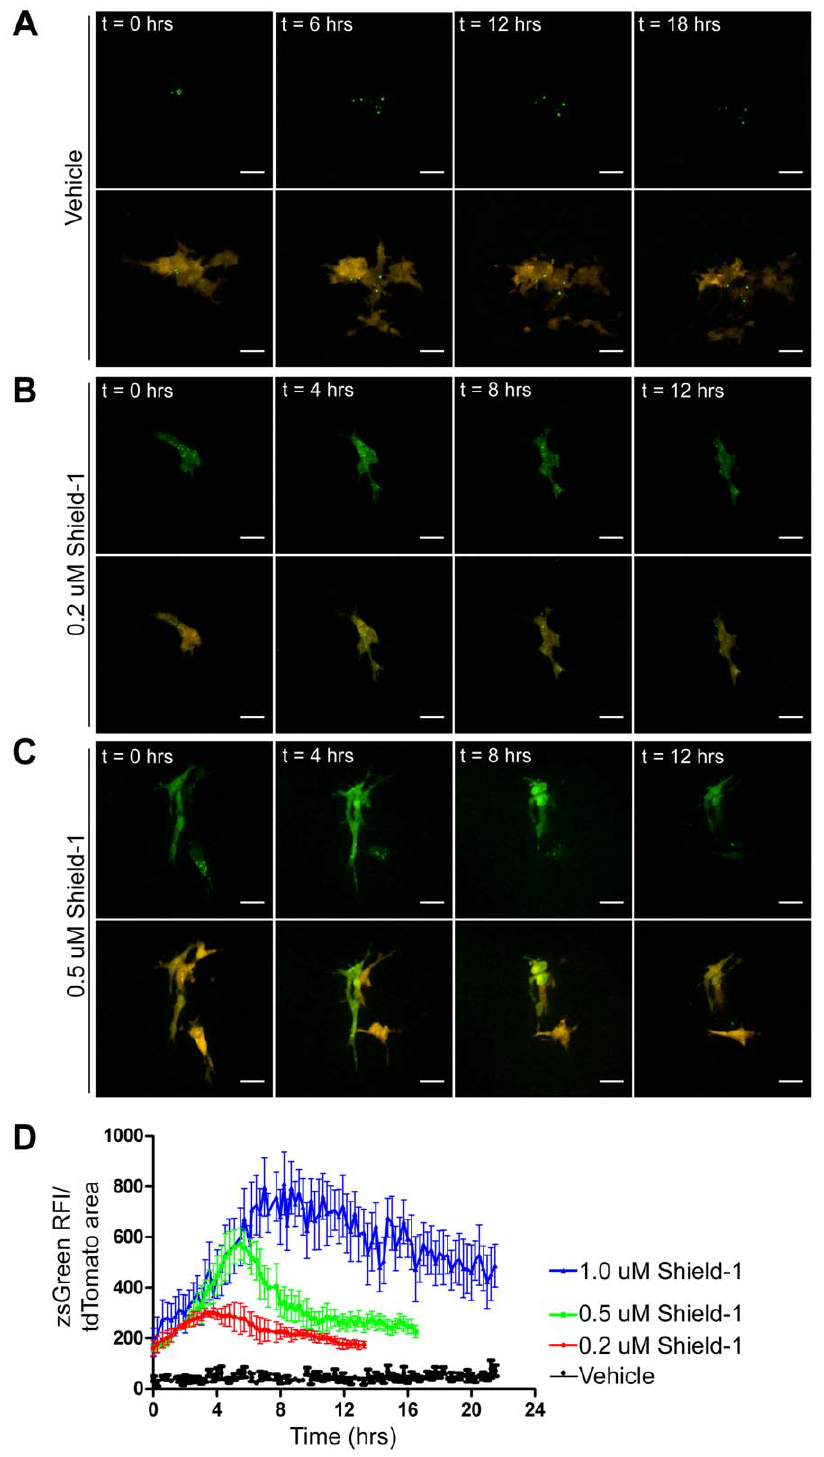
Figure 6. Intravital time-lapse imaging of fluorescent protein induction in 231LN cells invivo . 231LN cells expressing tdTomato (red) and inducible zsGreen-DD (green) were injected intravenously in the avian embryo and allowed to extravasate and proliferate into micrometastases. Representative time-lapse images (maximum intensity projections) are shown after intravenous administration of Vehicle (A), 0.2 m M Shield-1 (B), and 0.5 m M Shield-1 (C). D) Quantification of in vivo zsGreen fluorescence in tdTomato-positive cells over time. Data for Vehicle (black kinetic), 0.2 m M Shield-1 (red kinetic), 0.5 m M Shield-1 (green kinetic), and 1.0 m M Shield-1 (blue kinetic) are represented as averages of at least three movies analyzed in each group. Error bars are SE and scale bar represents 25 m m.